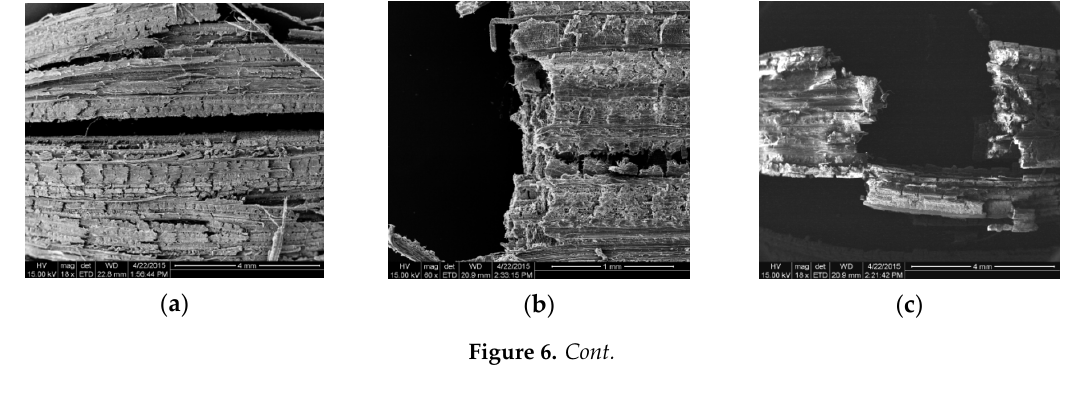
( f ) Figure 6. SEM images of typical tensile fracture surfaces of natural rattan bast strips evaluated in test 1: splintering tension ( a ), brash tension ( b ), and combined splintering and brash tension ( c ); natural rattan core strips: splintering tension ( d ), brash tension ( e ) and combined splintering and brash tension ( f ). ( a ) ( b ) Figure 7. SEM images of typical cross ‐ sections of fractured surfaces of bast ( a ) and core ( b ) rattan strip tested in tension.